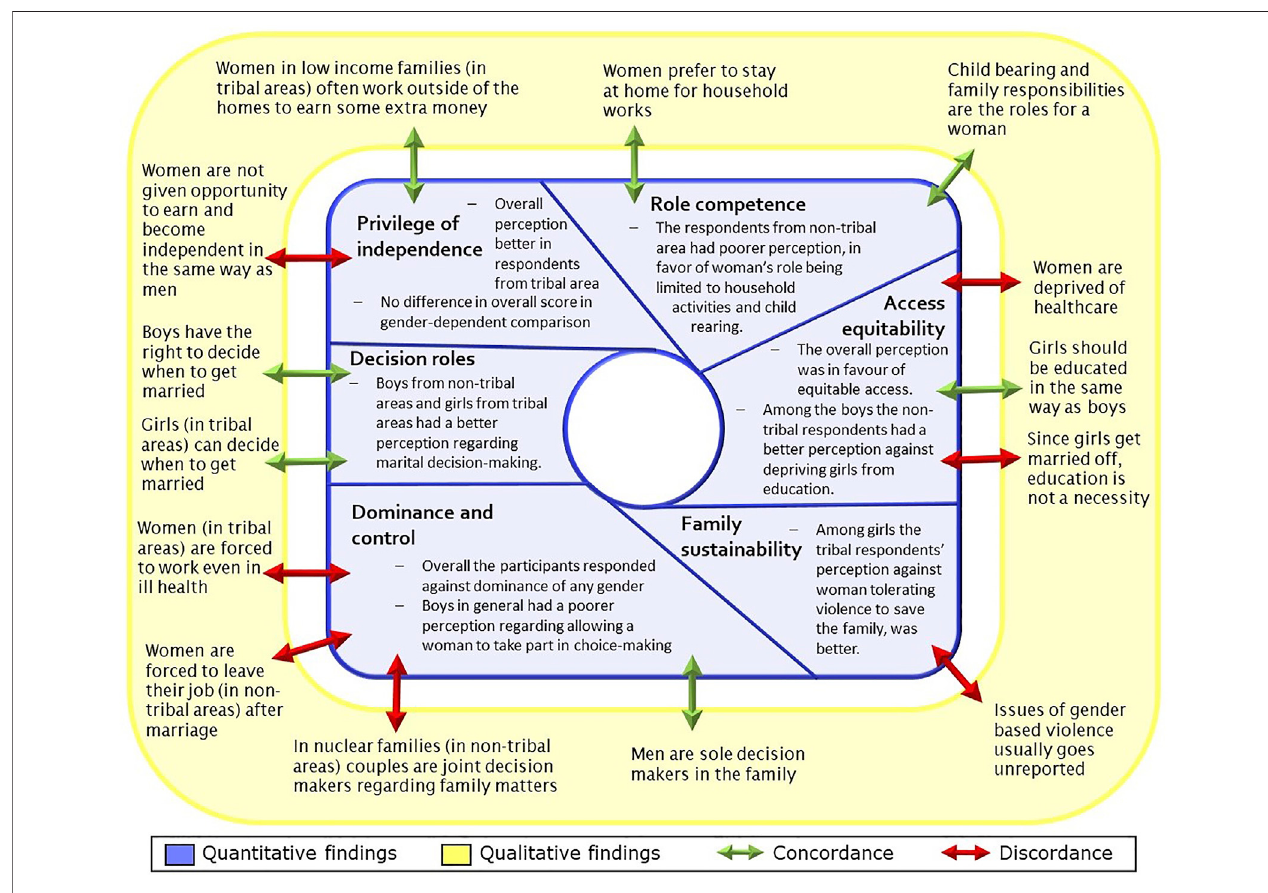
FIGURE 2 | Integration of quantitative fi ndings with qualitative fi